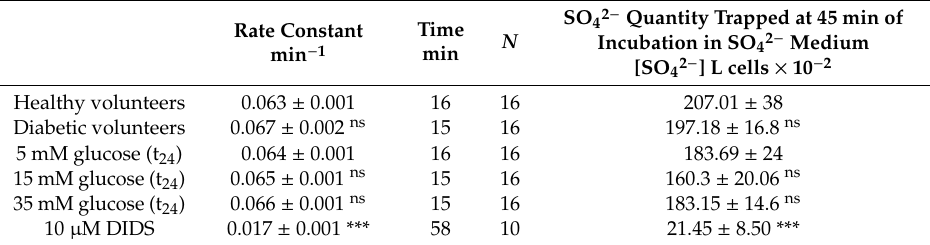
Table 2. Rate constant for SO 42 − uptake and quantity of SO 42 − trapped in both resealed ghosts of glucose-treated erythrocytes and in resealed ghosts from diabetic volunteers. Data are presented as means ± SEM from separate n experiments, where ns versus 5 mM glucose (t 24 ) and healthy volunteers (control); *** p < 0.001 versus control as determined by one-way ANOVA followed by Bonferroni’s post-hoc test.